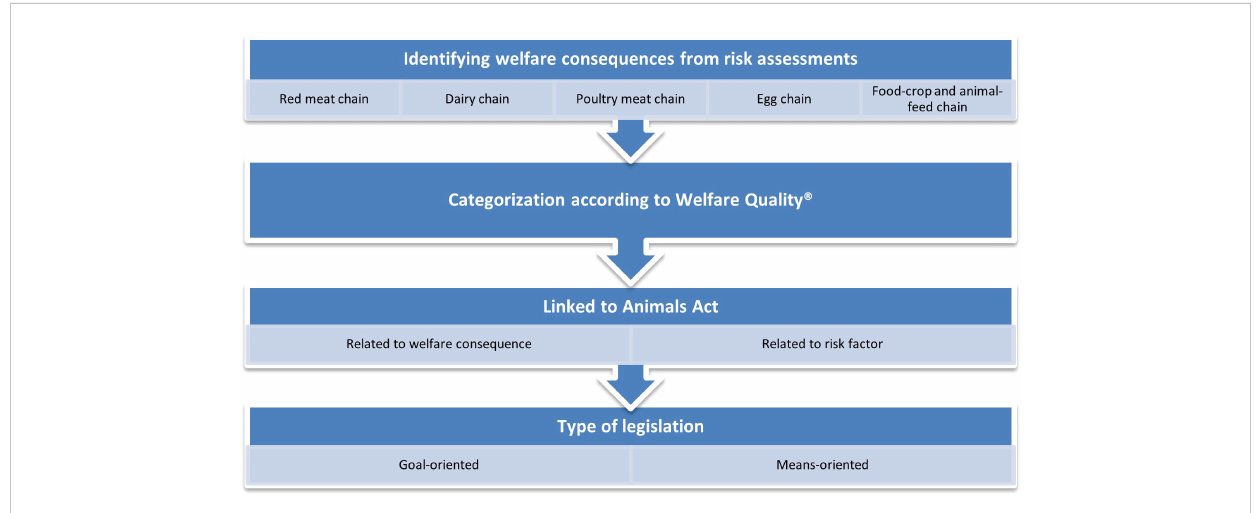
FIGURE 4 Simpli fi ed representation of the steps taken in this analysis to identify the welfare consequences in the various risk assessments and their representation in the legislation.